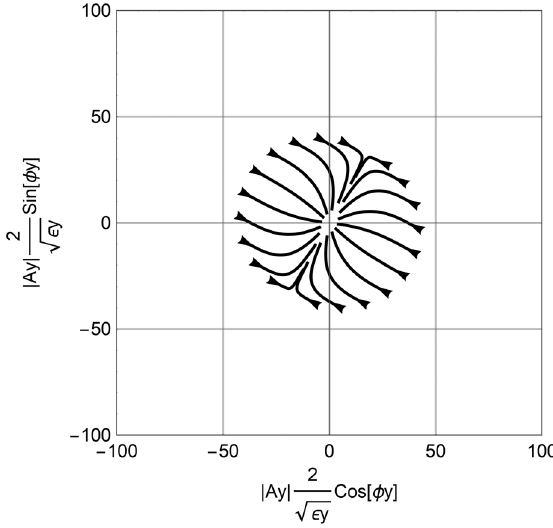
FIG. 18. Evolution of the average particle trajectories, solu- tion of Eqs. (49) and (50) with the same initial amplitude and different initial phases. Initial amplitude corresponds to 0 Þ ¼ 37 σ y 0 ð φ y ¼ y